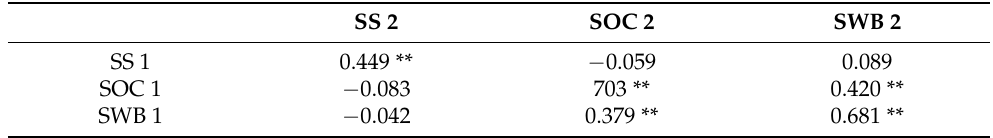
Table 3. Correlations among sense of coherence (SOC), subjective well-being (SWB), and school success (SS) before (1) and after mobility